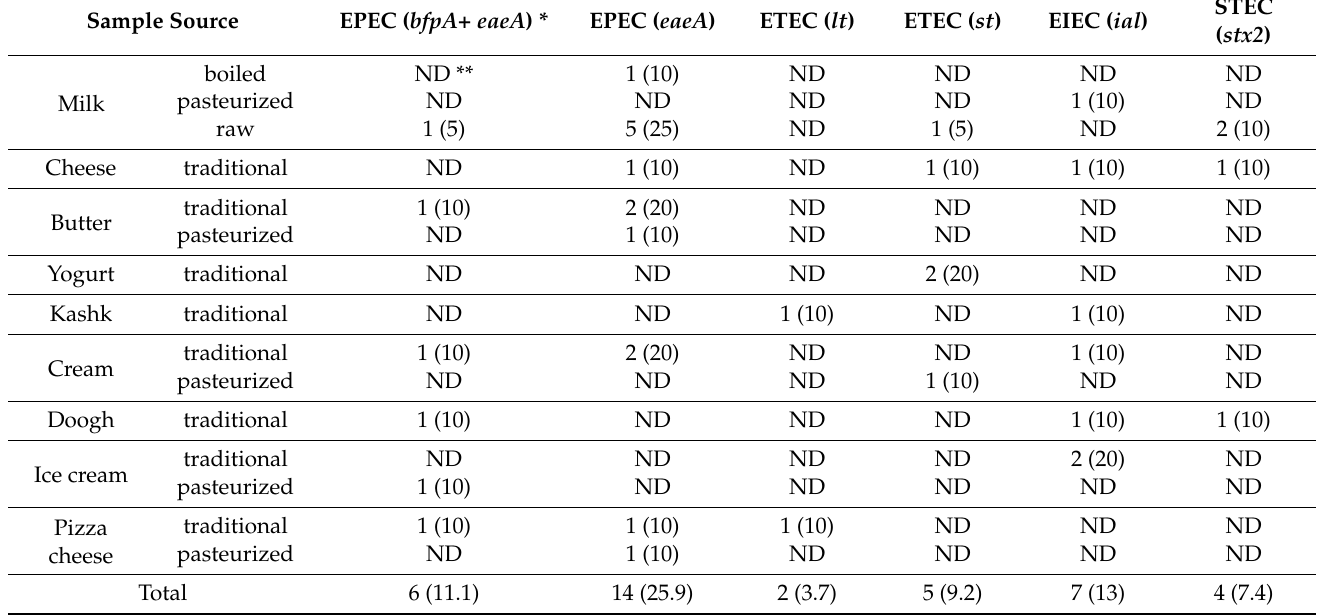
Table 2. Virulence genes in pathogenic E. coli isolates from traditional and pasteurized milk and dairy